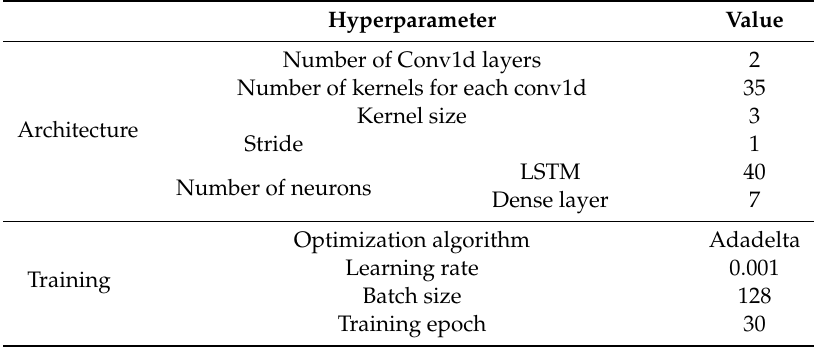
Table A4. Hyperparameter values for the CNN-LSTM.